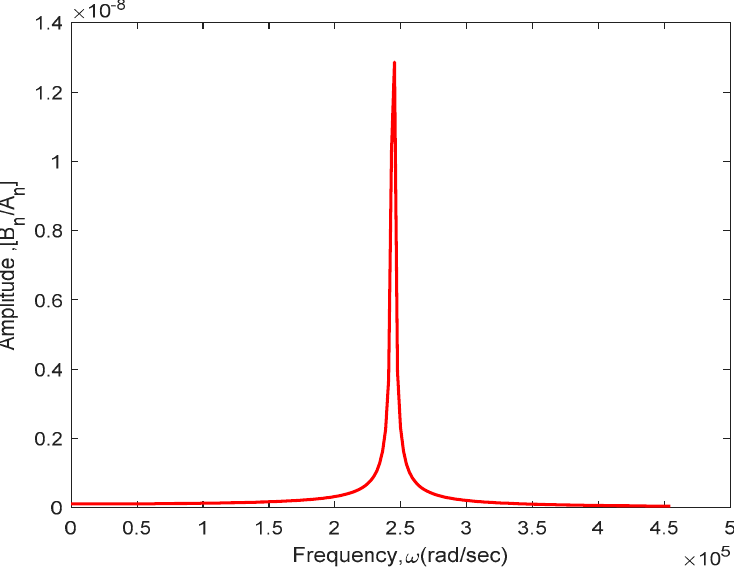
Figure 5. Amplitude ratio of displacement | 𝐵 (cid:2924) 𝐴 (cid:2924) ⁄ | .